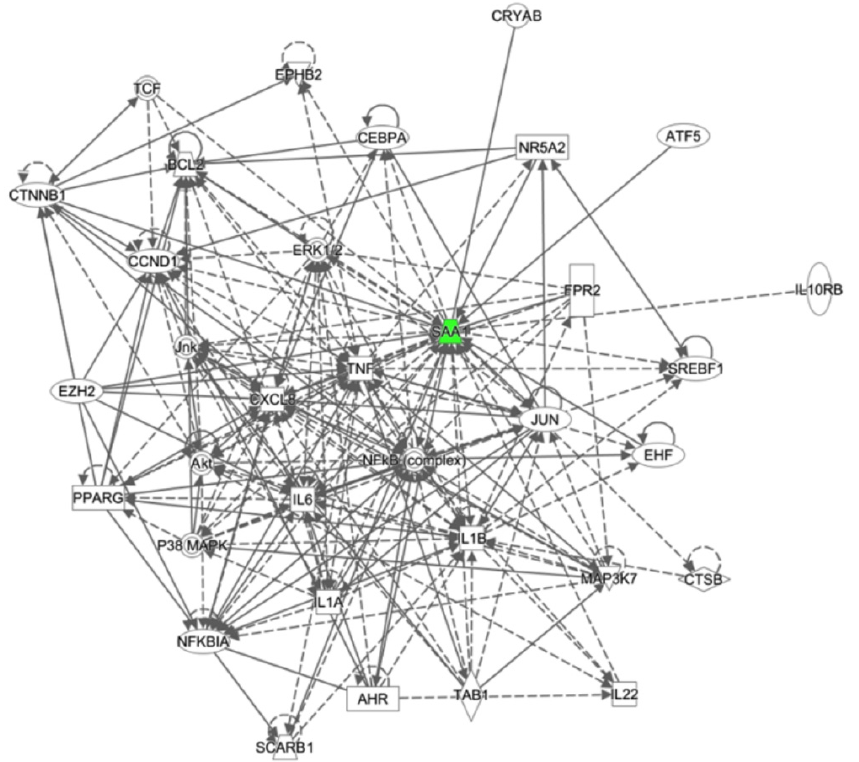
Figure 6. Network of tissue development, gene expression and cellular development related to M.BCG vs. P.BCG. Color codes: green, subexpressed. The color intensity indicates the degree of expression. Encoding form: rectangle—nuclear receptor ligand-dependent; oval—transcription regulator; rhombus—enzyme; circle—other.